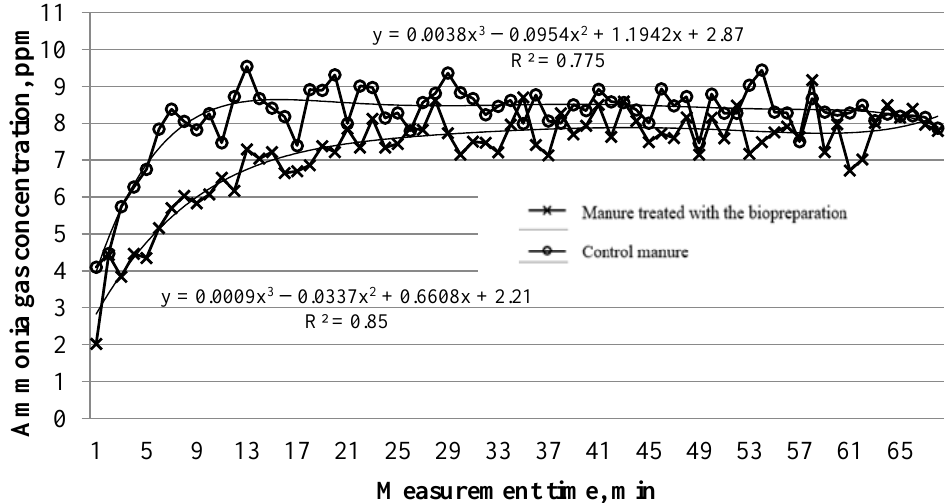
Figure 5. Change in ammonia concentration in the wind tunnel with the addition of the manure treated with the biopreparation and the control manure without additives (55 days after the addition of the biopreparation, the manure is